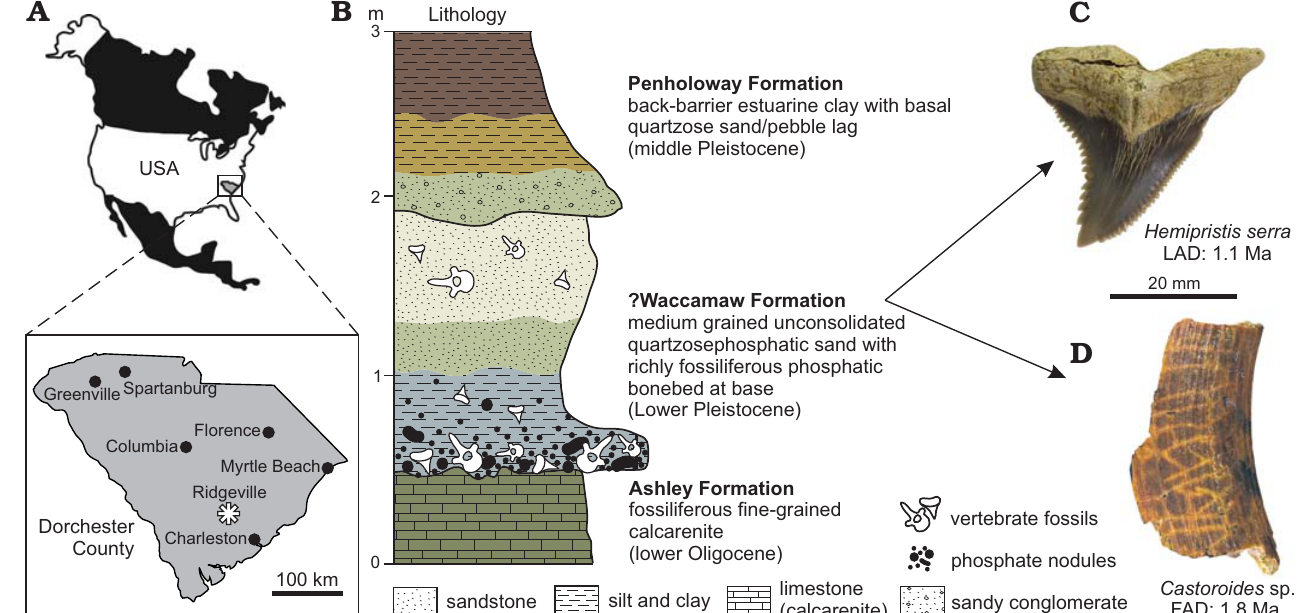
Fig. 1. A . Map showing the location of South Carolina and Austin Sand Pit near Ridgeville in Dorchester County (asterisked). B . Generalized stratigraphic column of the Austin Sand Pit with biostratigraphically significant vertebrate fossils from the ?Waccamaw Formation ( C , D ). Colors approximate sedi- ments exposed in the Austin Sand